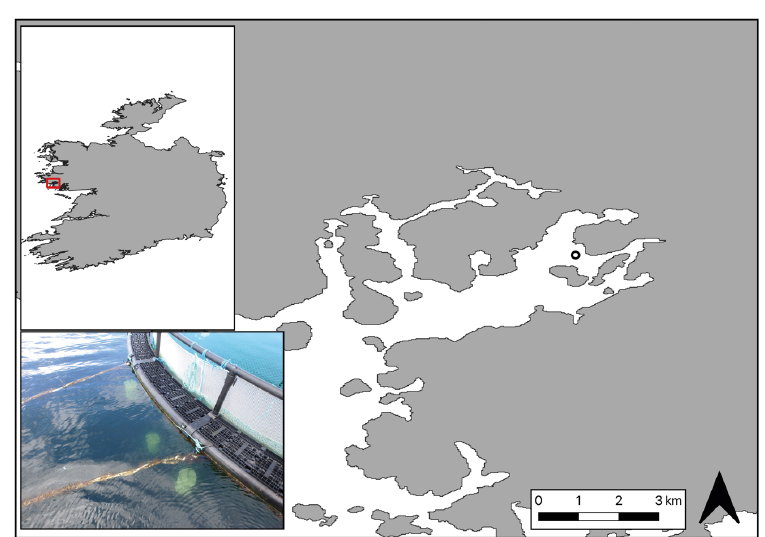
Fig. 1. Bertraghboy Bay, Ireland, and the location of the marine research site. The photograph shows the cage site and the sea-based container culture (SBCC) structures. The black circle indicates the location of the experimental site in relation to the Irish West